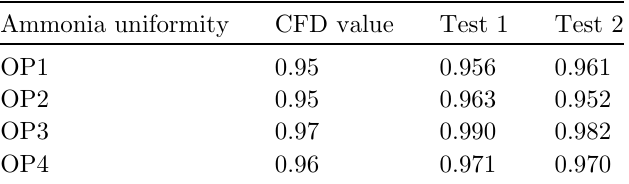
Table 8. Simulation and experimental data.